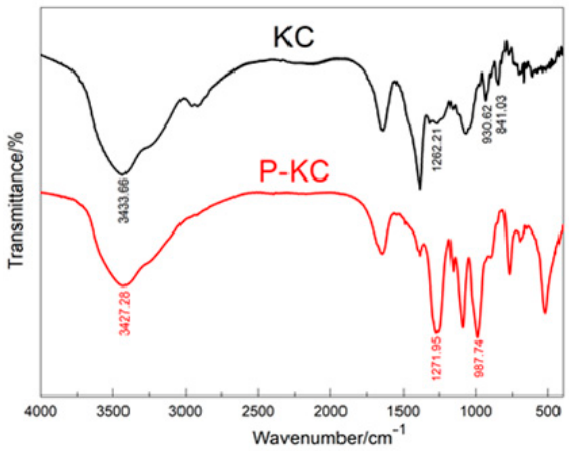
Figure 2. Fourier transform infrared spectroscopy (FTIR) spectra of KC and P-KC.